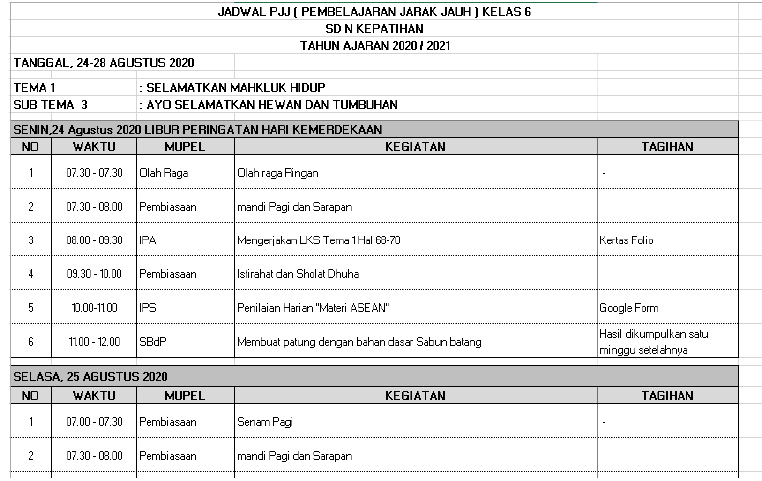
Figure 1 : Example of class 6 PJJ schedule